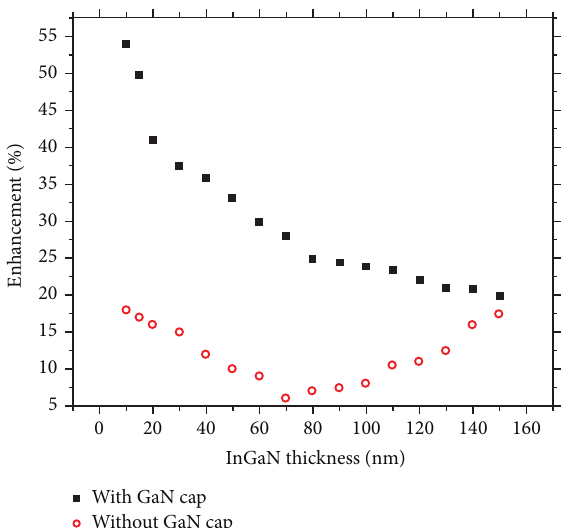
Figure 7: Calculated short-circuit current density enhancement versus the InGaN layer thickness demonstrating the improvement as a result of the structure design incorporating the GaN cap